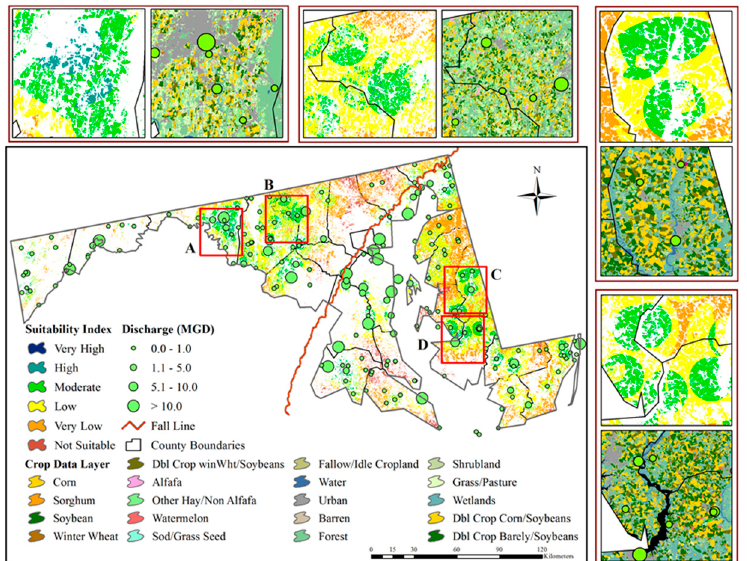
Figure 7. The composite suitability map showing the hotspot of the suitable agricultural lands ranging from “high” to “very low” index for recycled water irrigation. Four clustered suitability zones are showing with existing crops pattern in the boxes.